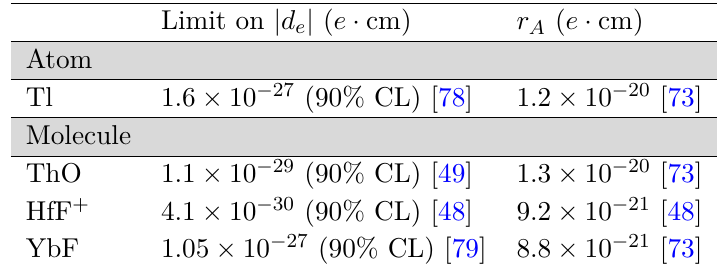
d e for C S = 0 and the coefficient r A for each paramagnetic | |